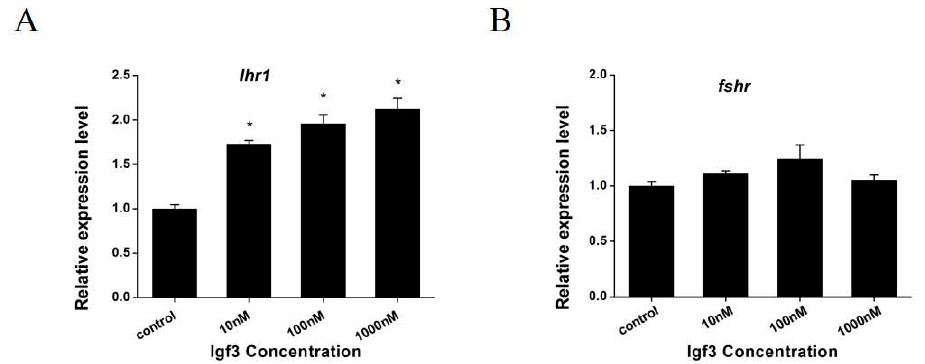
Figure 8. Effects of Igf3 treatment on primary ovarian cells on the expression of reproduction-related genes. ( A ) ihr1 and ( B ) fshr at the indicated dosages. ( n = 4). *, p < 0.05.